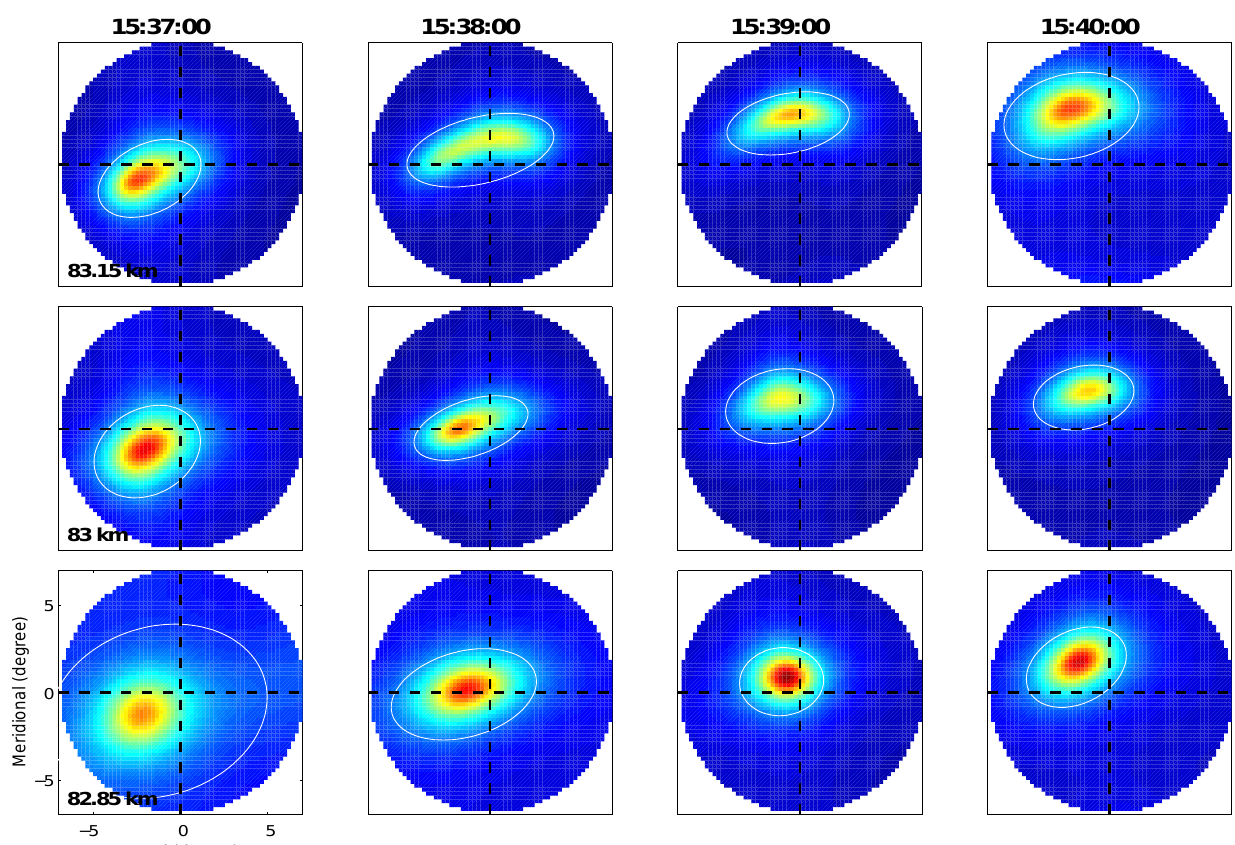
Fig. 2. Examples of the brightness distribution of PMSE that are estimated using Capon CRI. Each image shows the PMSE structure within the radar beam from − 7 ◦ to 7 ◦ and is estimated every 50s. The range of values shown in each image ranges from 0 to 1. By applying a two-dimensional Gaussian fitting algorithm, a set of parameters ( µ x , µ y , σ x , σ y , and ρ ) can be determined. The white contour lines indicate a constant value of 0.1 using the estimated Gaussian